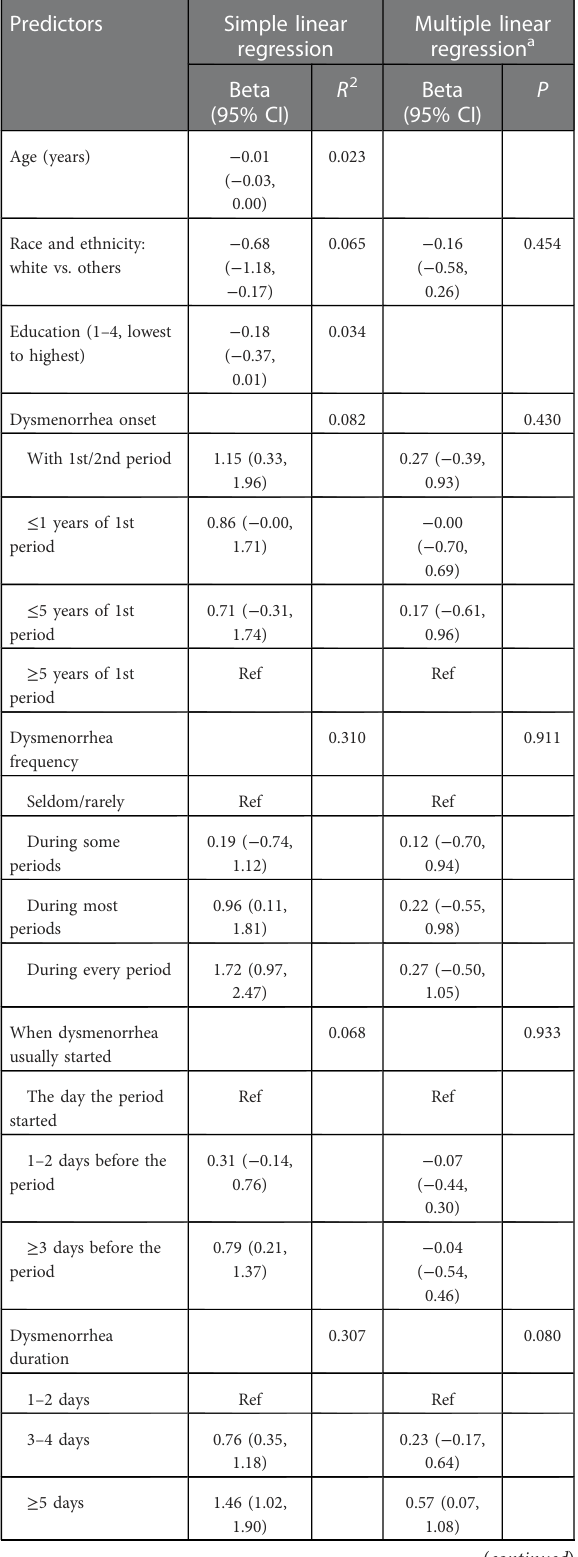
TABLE 6 Predictors of dysmenorrhea catastrophizing, results from simple and multiple linear regression models a .